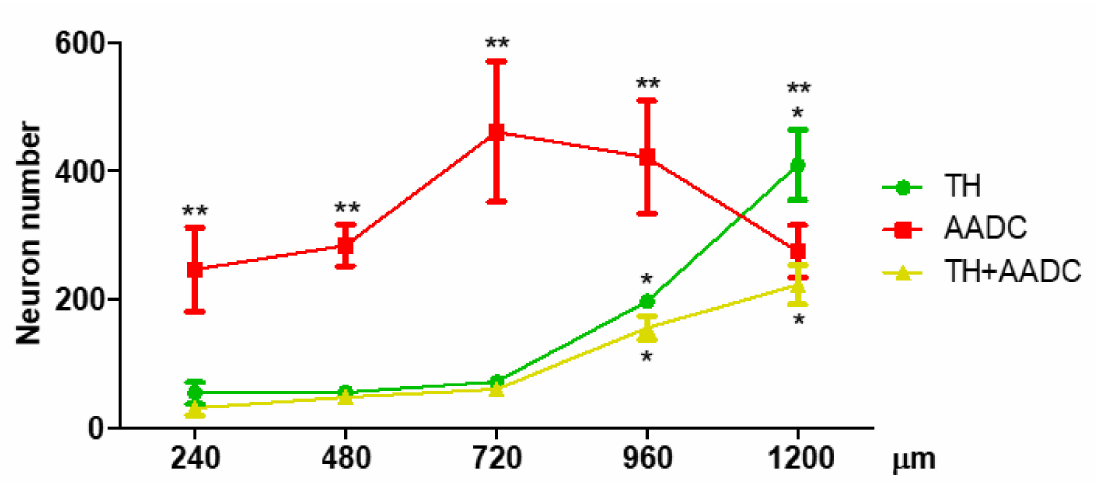
Figure 7. Number of neurons that were immunopositive for tyrosine hydroxylase (TH) only, aromatic L-amino acid decarboxylase (AADC) only, and both dopamine-synthesizing enzymes—TH and AADC, at various frontal levels of PeVN in the rostro-caudal direction. * p < 0.05, significant differences in the number of immunopositive neurons of each population at the adjacent frontal levels of the PeVN in the rostro-caudal direction; ** p < 0.05, significant differences between the number of immunopositive neurons of different populations at the same frontal level of PeVN in the rostro-caudal